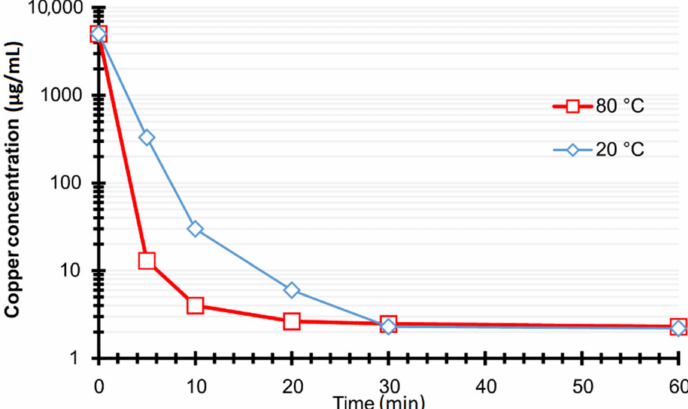
Figure 11. Copper concentration change over time at temperature of 20 and 80 ◦ C.